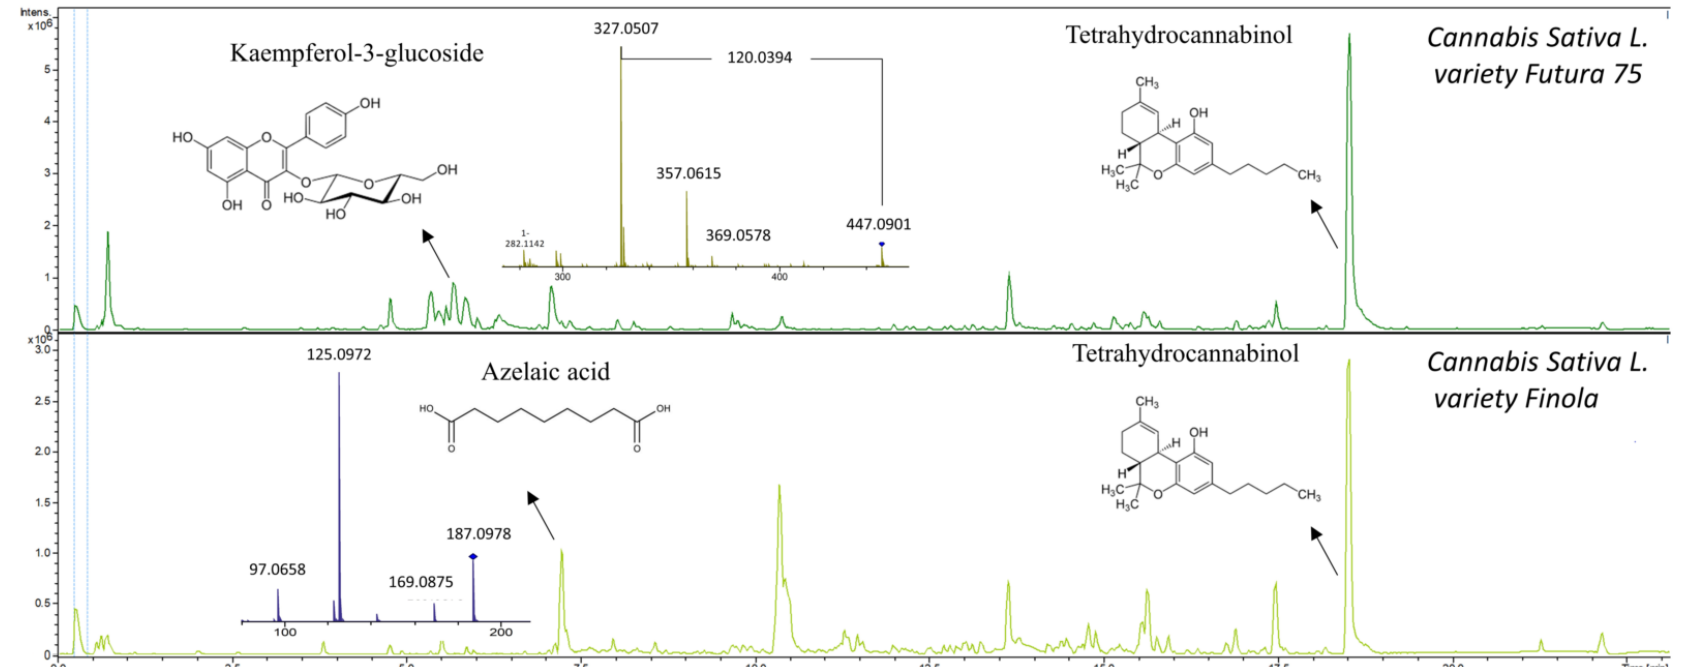
Figure 4. Metabolic profiles of Cannabis sativa L. variety Futura 75 and Cannabis sativa L. variety Finola showing MS 2 spectra of kaempferol-3-glucoside and azelaic acid. Tetrahydrocannabinol was also tentatively identified.